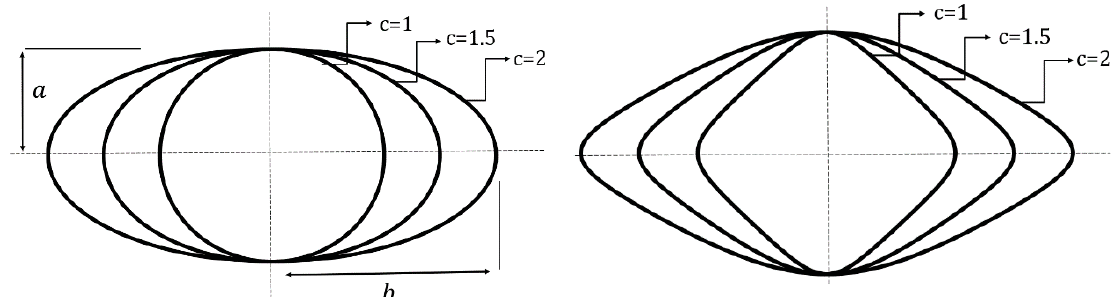
Figure 5. Effect of c parameter on the shape of circular cutout w = 0, θ 3 = 90 ◦ ( left ), effect of c parameter on the shape of quasi-square cutout w = 0.1, θ 3 = 90 ◦ ( right